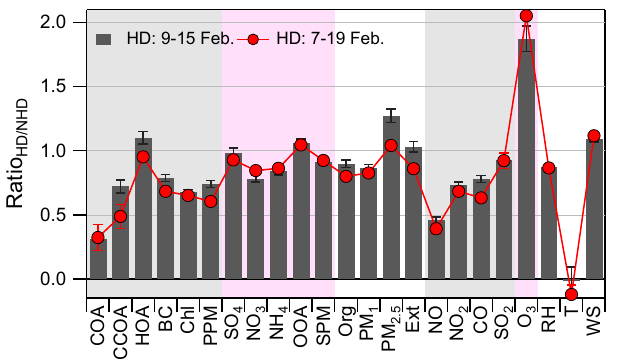
Figure 9. The average ratios of aerosol species, gaseous species, PM mass concentrations, extinction coefficient, and meteorological parameters between holiday (HD) and non-holiday (NHD) periods. Two different holidays, i.e., the official holiday of 9–15 February and the longer holiday of 7–20 February were used for averages. Also note that the averages were made by excluding clean periods and firework events during both HD and NHD days. The error bars are the standard errors of the